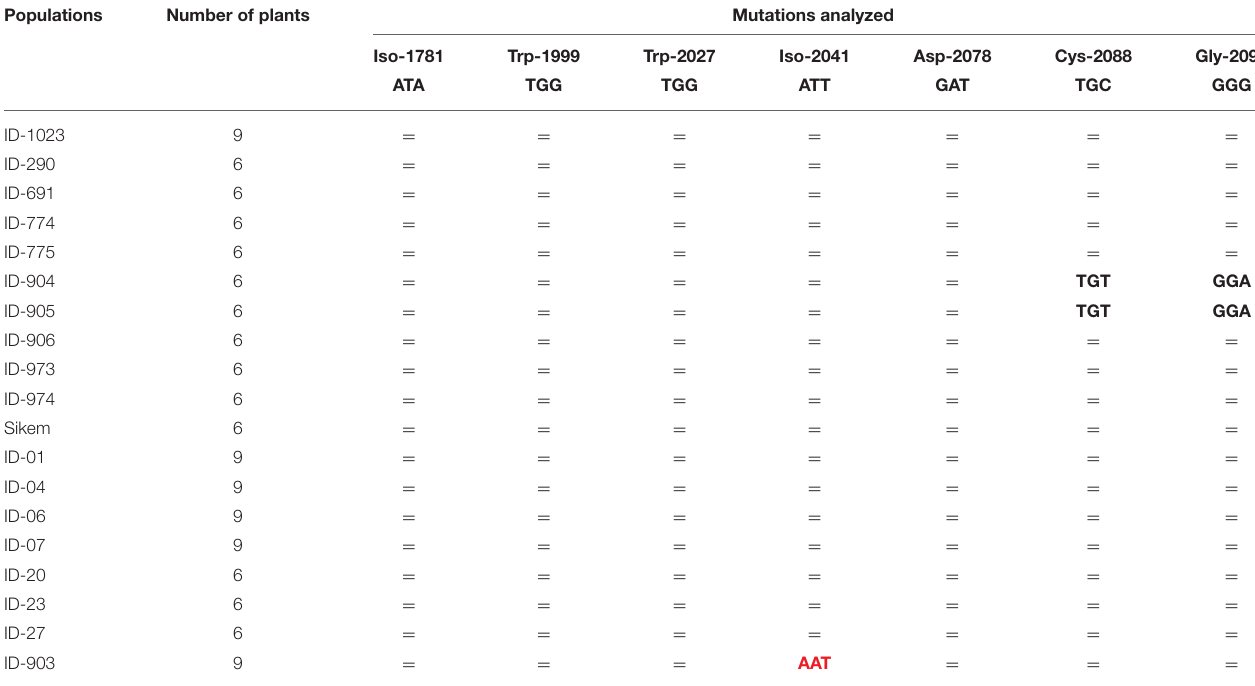
TABLE 4 | Genotyping of various L. multiflorum populations to detect specific point mutations in ACCase ( = no mutation).